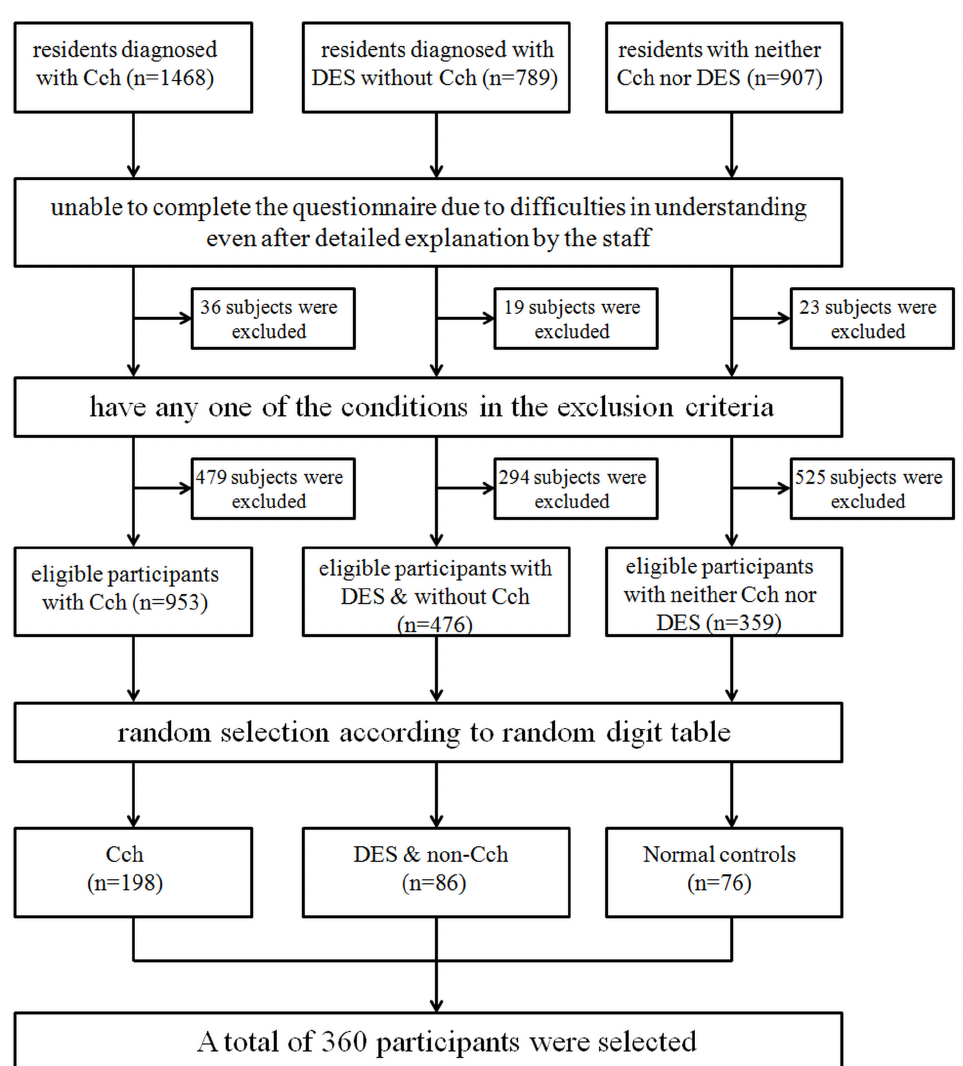
Figure 1. The protocol for the study population selection is shown here.